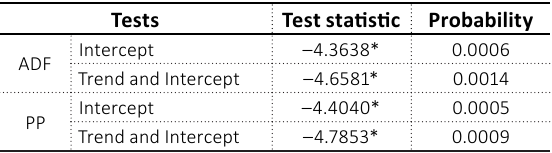
Table 8. Stationarity test results